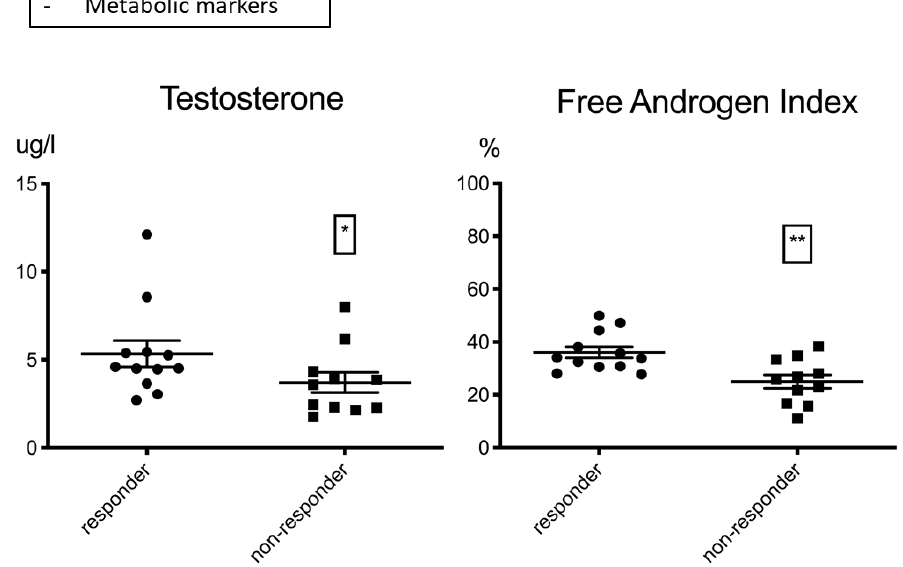
Figure 3. Testosterone µ g/L ( left ) and the free androgen index % ( right ) shown for male responders and non-responders. Higher levels were associated with response to treatment. Significance was indicated as * p < 0.05, ** p <